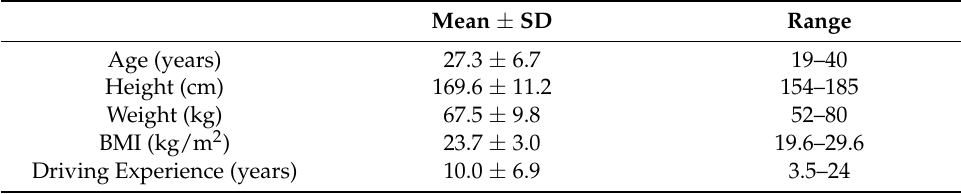
Table 2. Laboratory vibration study participants’ demographic summary ( n = 10].